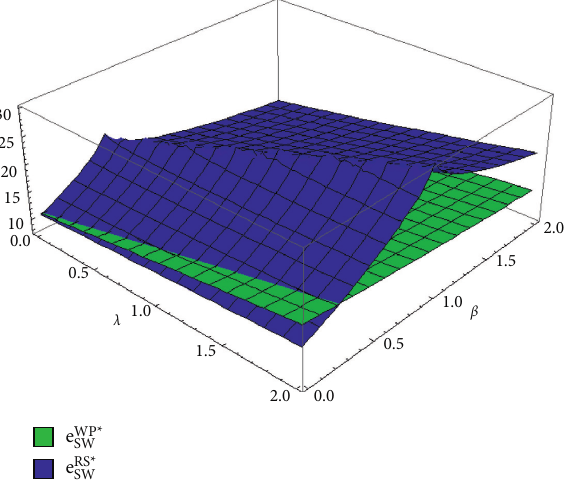
Figure 12: Effect of λ and β on the retailer’s expected